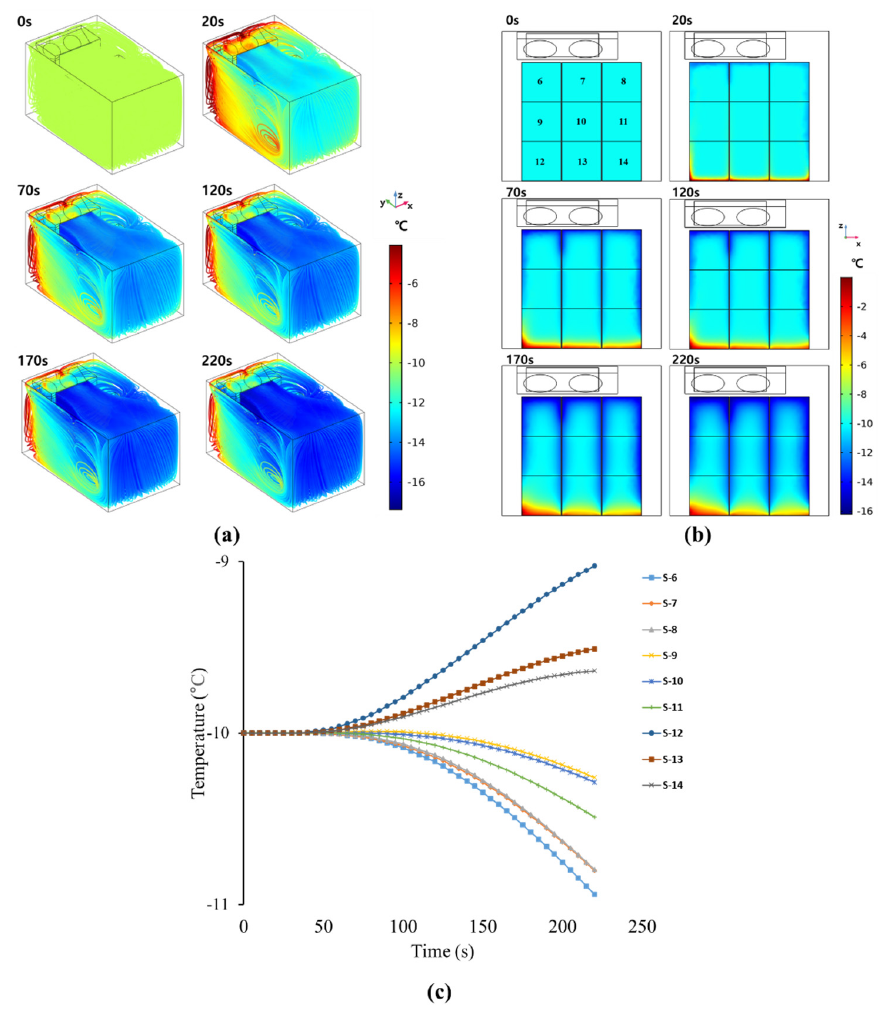
Figure 11. Temperature change over time: ( a ) 3D streamlines in the refrigerated body, ( b ) middle slide inside the boxes, and ( c ) inner center of the box at each box point ( b ) with time.